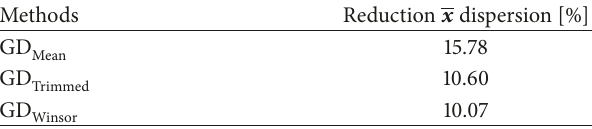
Table 24: Log-normal with 100 points.